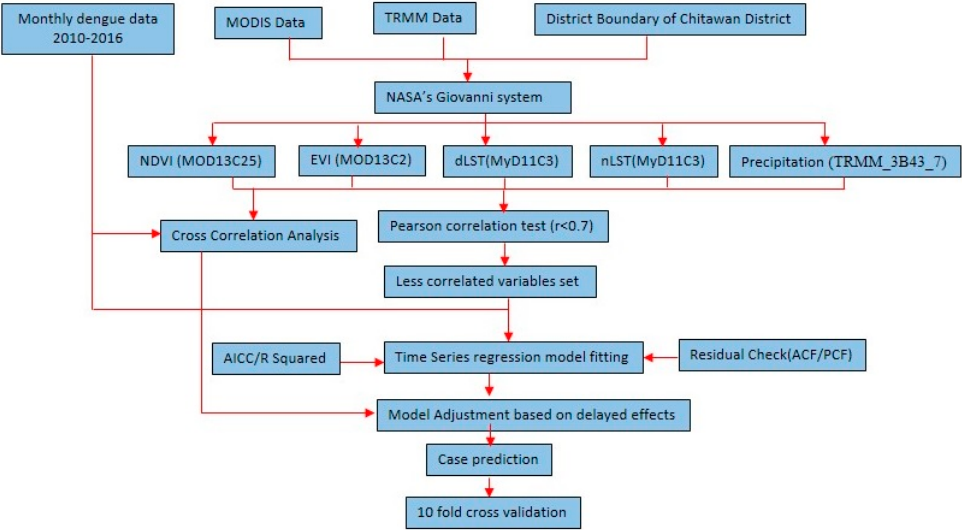
Figure 2. Methodological workflow.